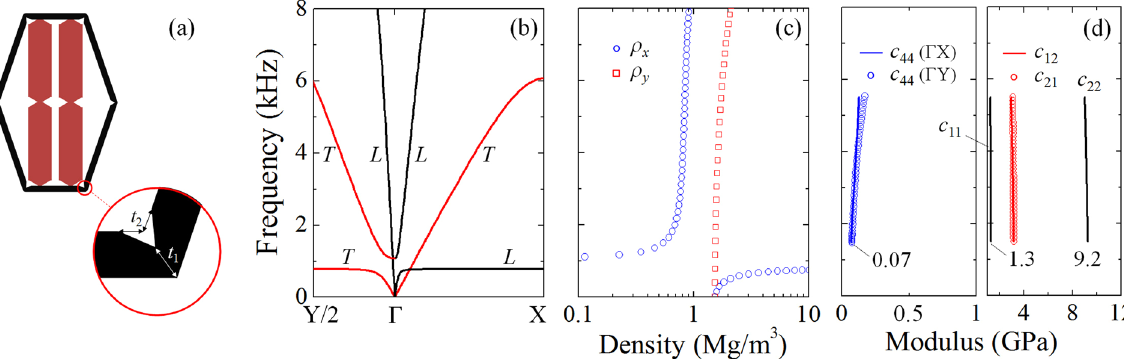
Figure 5. Realistic model and wave characteristics of pentamode-inertial materials. ( a ) The reduced model of the metasolid wherein all lattice beams are sharpened at ends with parameters t 1 = t 2 = t /2; ( b ) band structures, ( c ) effective inertial densities, and ( d ) overall stiffness parameters computed for the modified model. This reduced metasolid, whose shear stiffness c 44 has been diminished remarkably, behaves like the pentamode- inertial material, which is the general material model following transformation acoustic